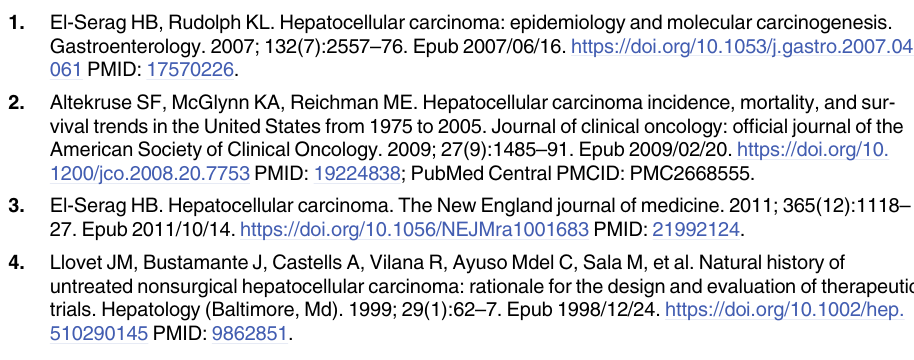
S2 Table. Search Strategy Used in Embase. S3 Table. Evaluation of quality of included studies using the QUADAS-2